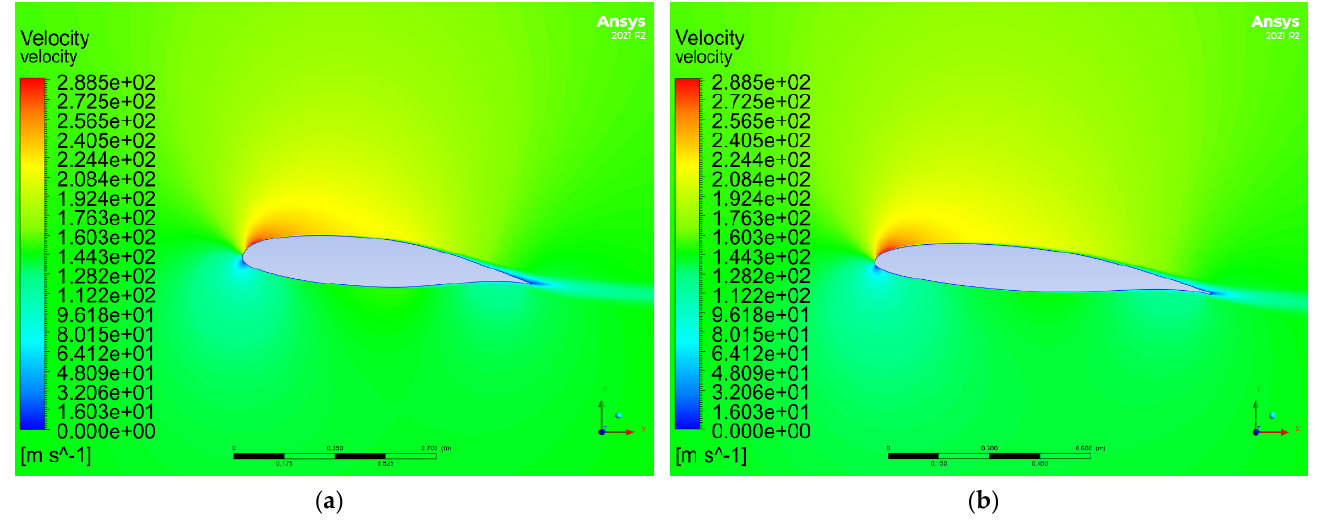
Figure 7. CFD flowfield of two airfoils with velocity field; GA(W)-1 ( a ); GA(W)-2 ( b ). The results of the wing aerodynamic performance calculations using the lifting line theory are shown in Figure 8. The investigated wing geometries had the same span as the original wing; they differed from each other by having reduced chords in defined proportions. This reduced the total area of the wing. Figure 8a shows that the aerodynamic drag coefficient decreased with decreasing the wing area. The lift and drag coefficients are shown here relative to the area of the original wing. The dash dotted line shows the amount of lift required for cruise mode. The values of aerodynamic drag interpolated for the required lift as a function of wing area are shown in Figure 8b. From the results it can be deduced that the drag of a wing with 65% of the area of the original wing had approximately 20% less drag.